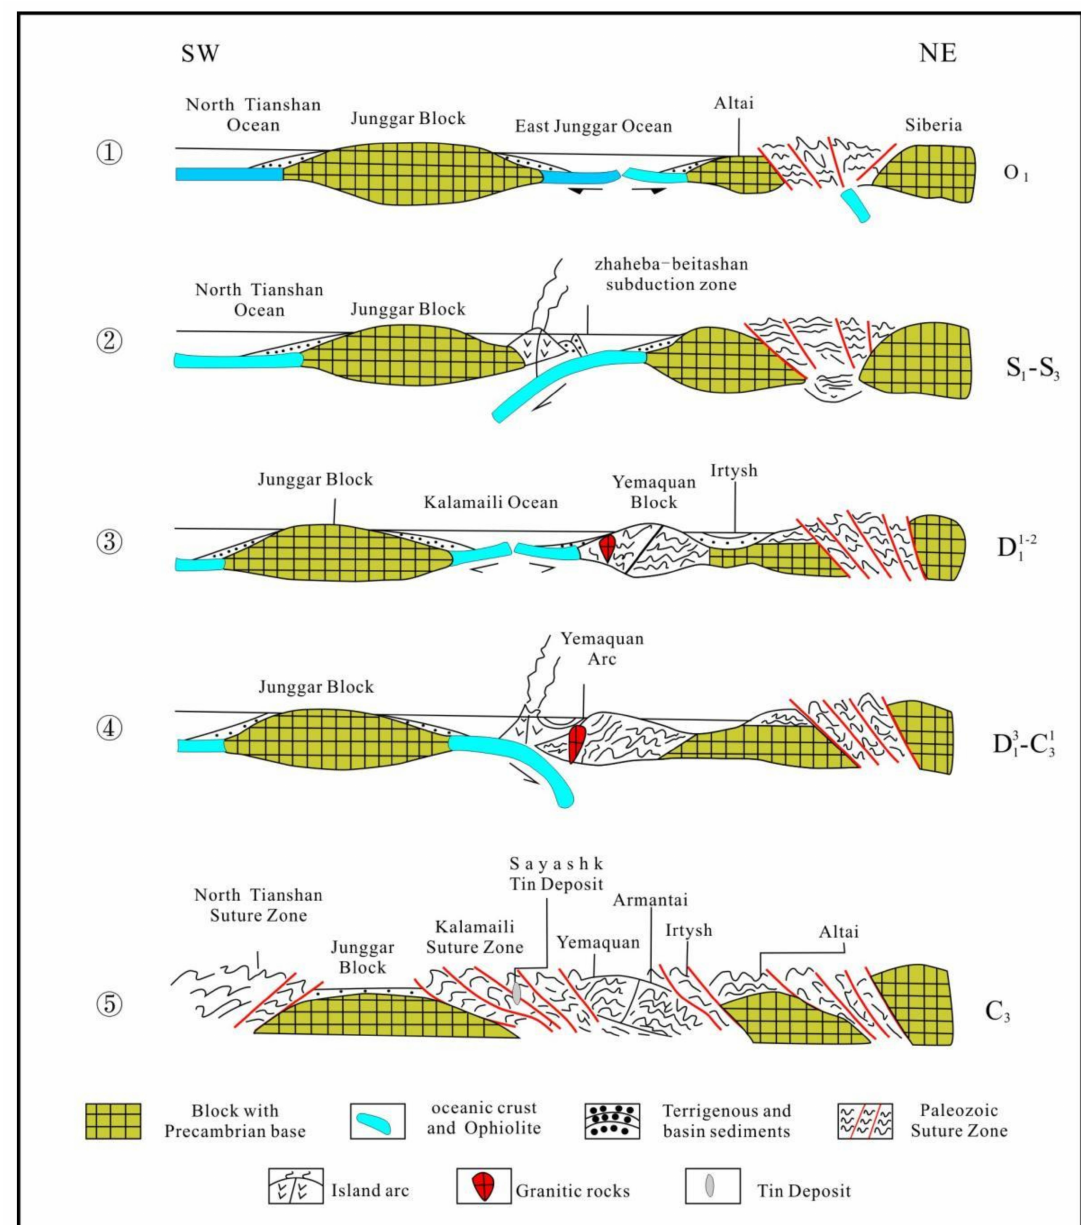
Figure 14. Diagram of Paleozoic tectonic evolution in East Junggar